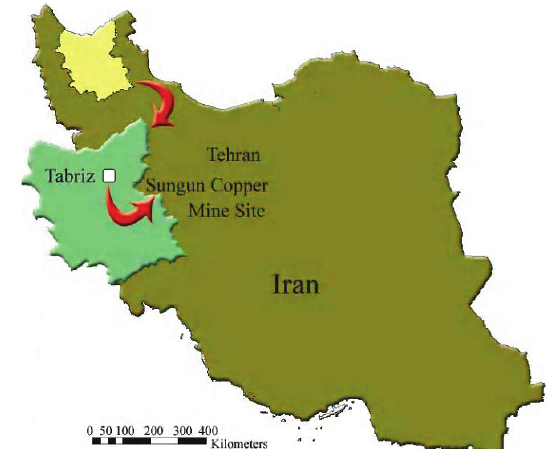
figure 3. The proposed model